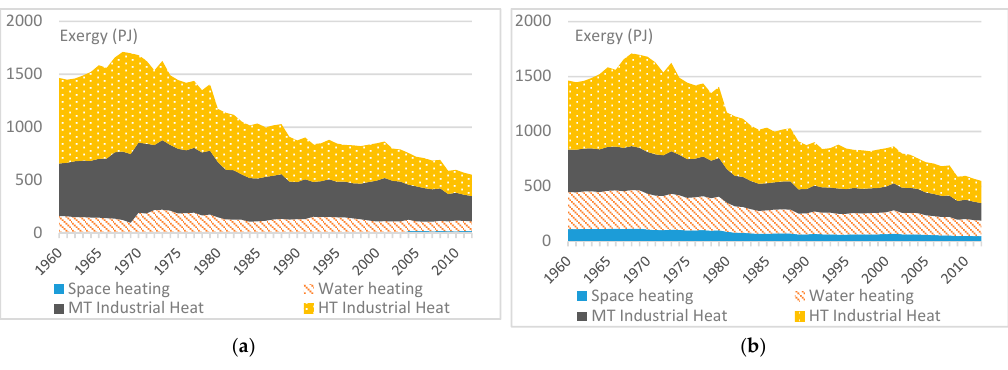
Figure 3. Final exergy of UK industrial heat from combustible fuel energy carriers, disaggregated by end-use: ( a ) Using previous allocation method; ( b ) Using updated allocation method.